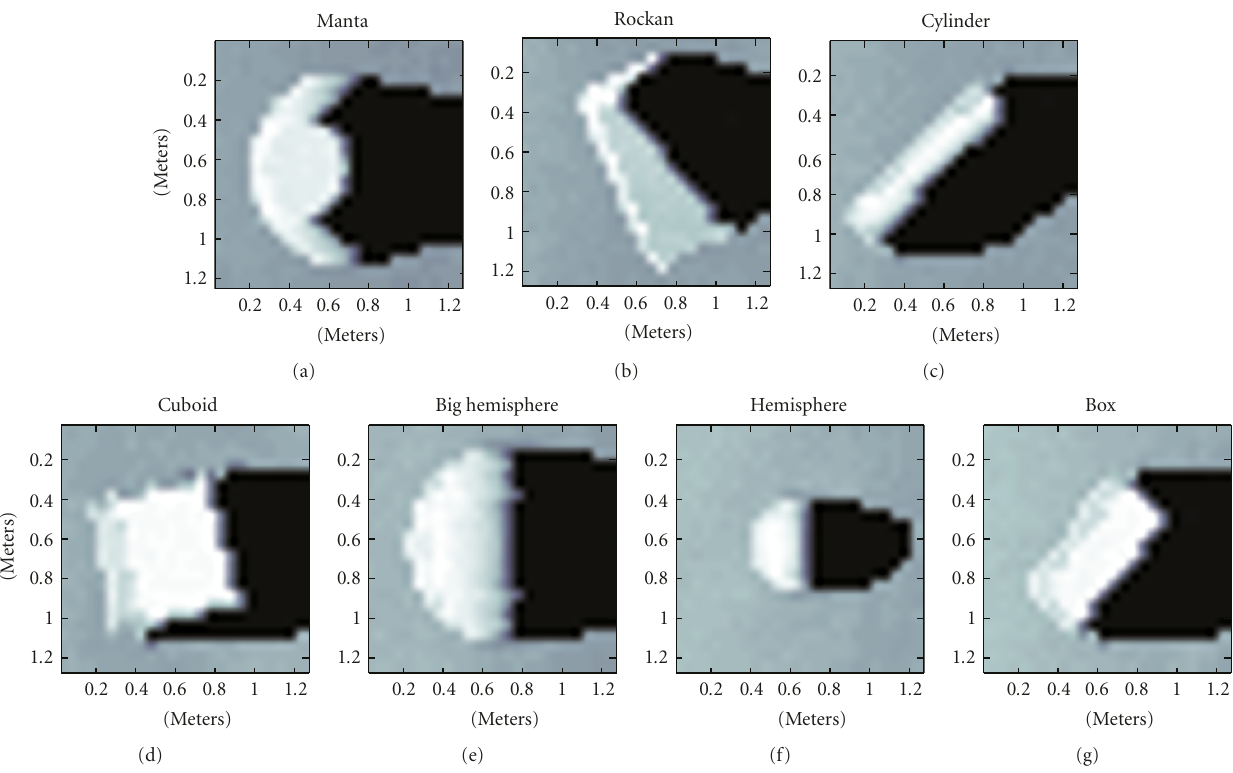
Figure 12: Snapshot of the targets used for classification. On the first line, the minelike targets with the Manta, the Rockan and the cylinder. On the second line, the nonmine targets with the cube, the two hemispheres, and the box shape target. The pixel size in these targets images is 5 cm.